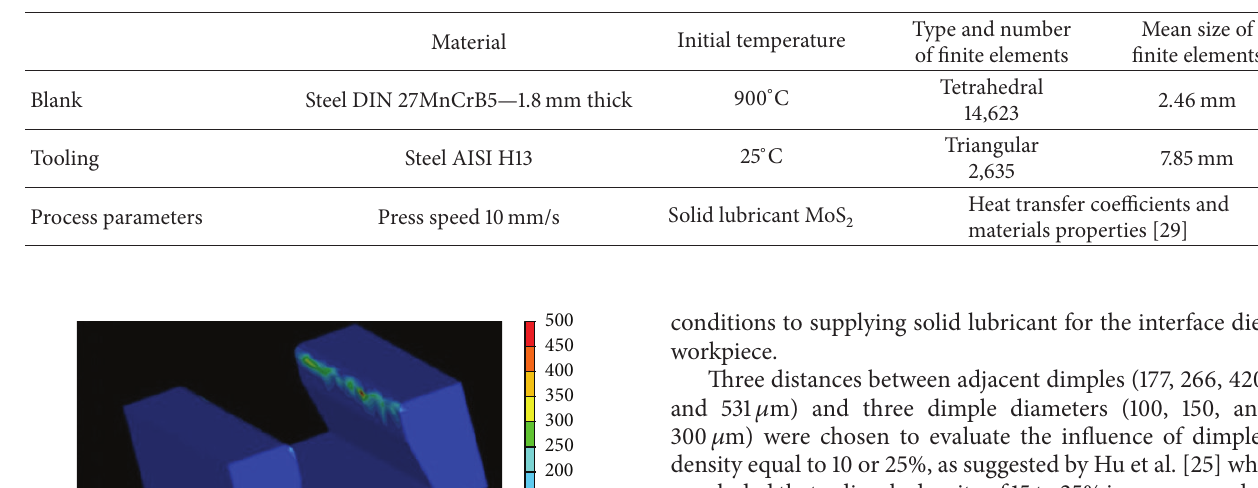
Table 1: Inputs for the numerical simulation.